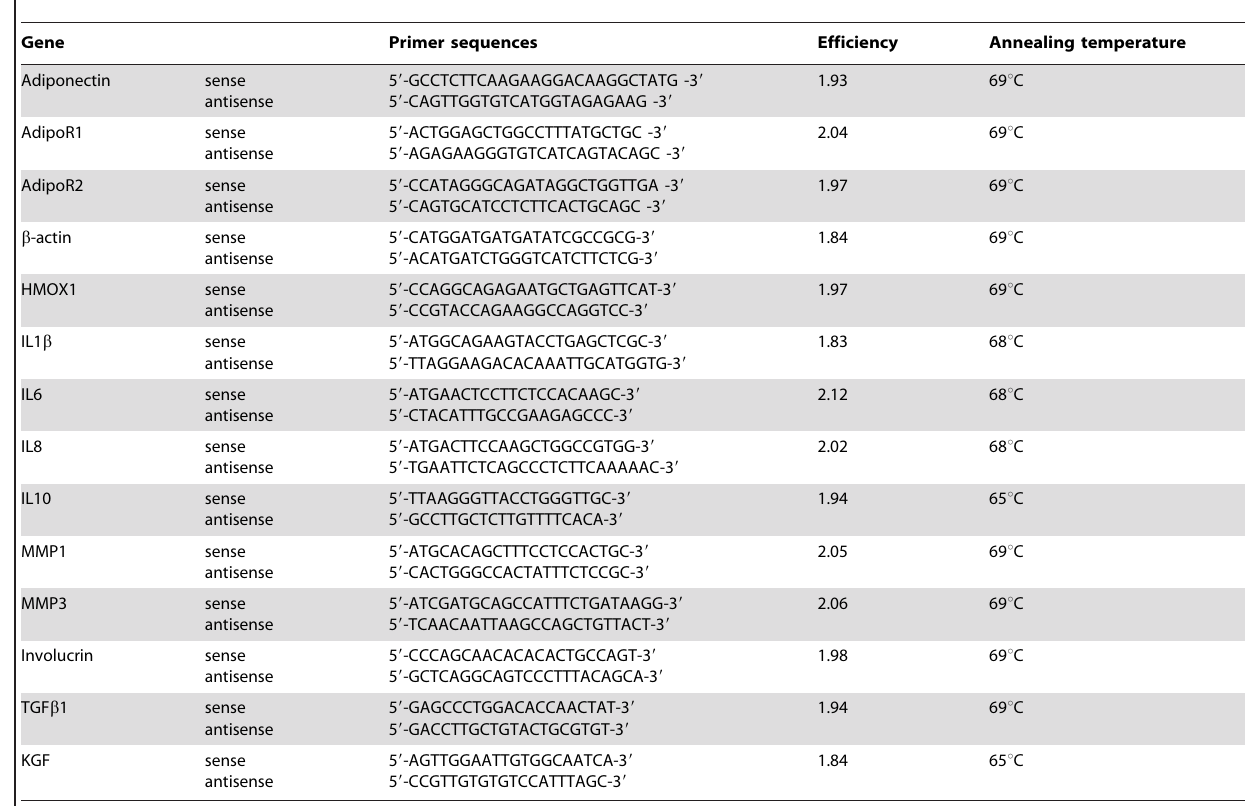
Table 1. Sequences, efficiency and annealing temperature of primers.